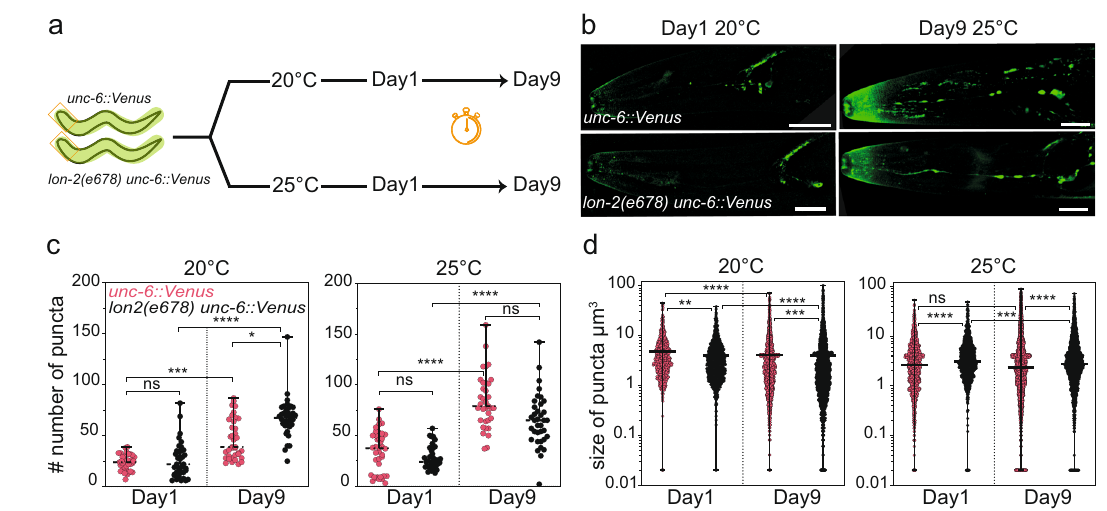
Fig. 8 | Physiological relevance of the NET1 Δ C-GAG interaction in the model system C.elegans (part2).a Schematicrepresentationofwork fl owforNET1/UNC- 6 puncta scoring. b Representative confocal fl uorescent images of NET1/UNC-6 puncta in the head region of day 1 and day 9 adult worms grown at 20°C or 25°C. Scale bar: 20 µ m. c Quanti fi cation of number of NET1/UNC-6 puncta per animal in the headregion of day1and day9 adultwormsgrown at 20°C or25°C.Meanwith range and results for Kruskal – Wallis Dunn ’ s multiple comparisons test are